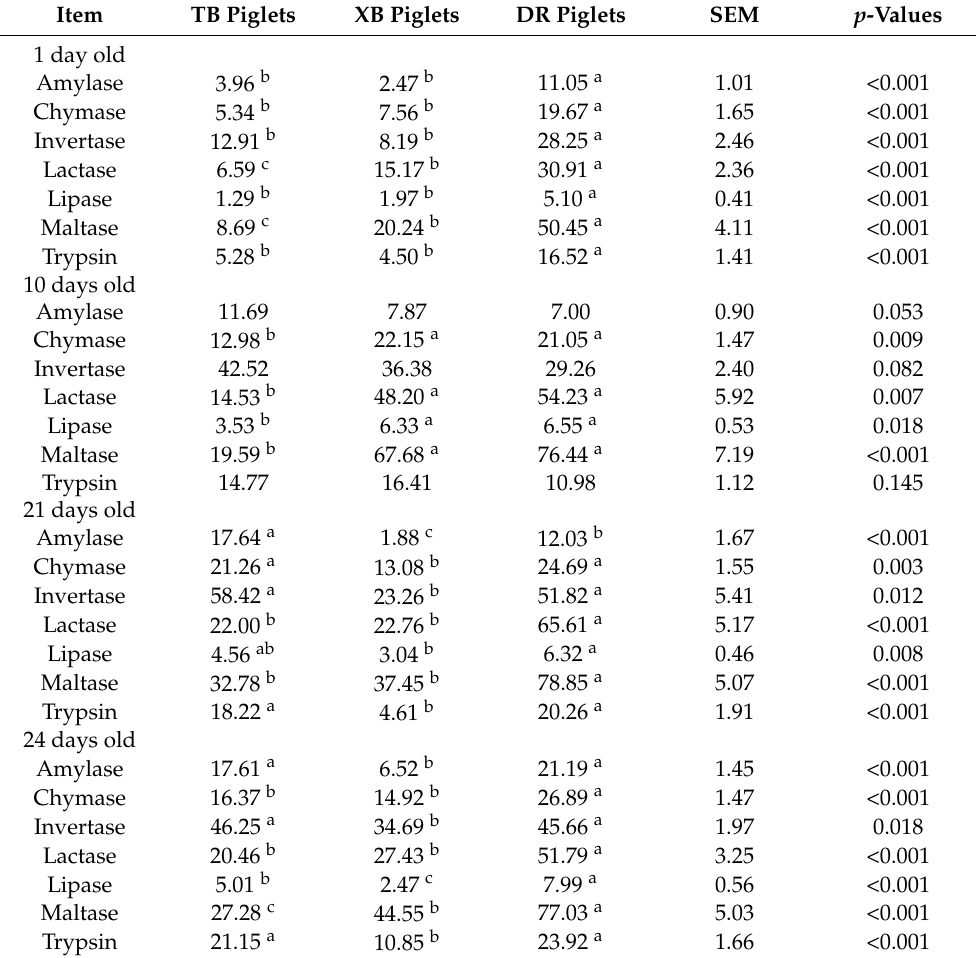
Table 7. Differences in the ileal digestive enzyme activities of piglets at different ages (U/g). Item TB Piglets XB Piglets DR Piglets